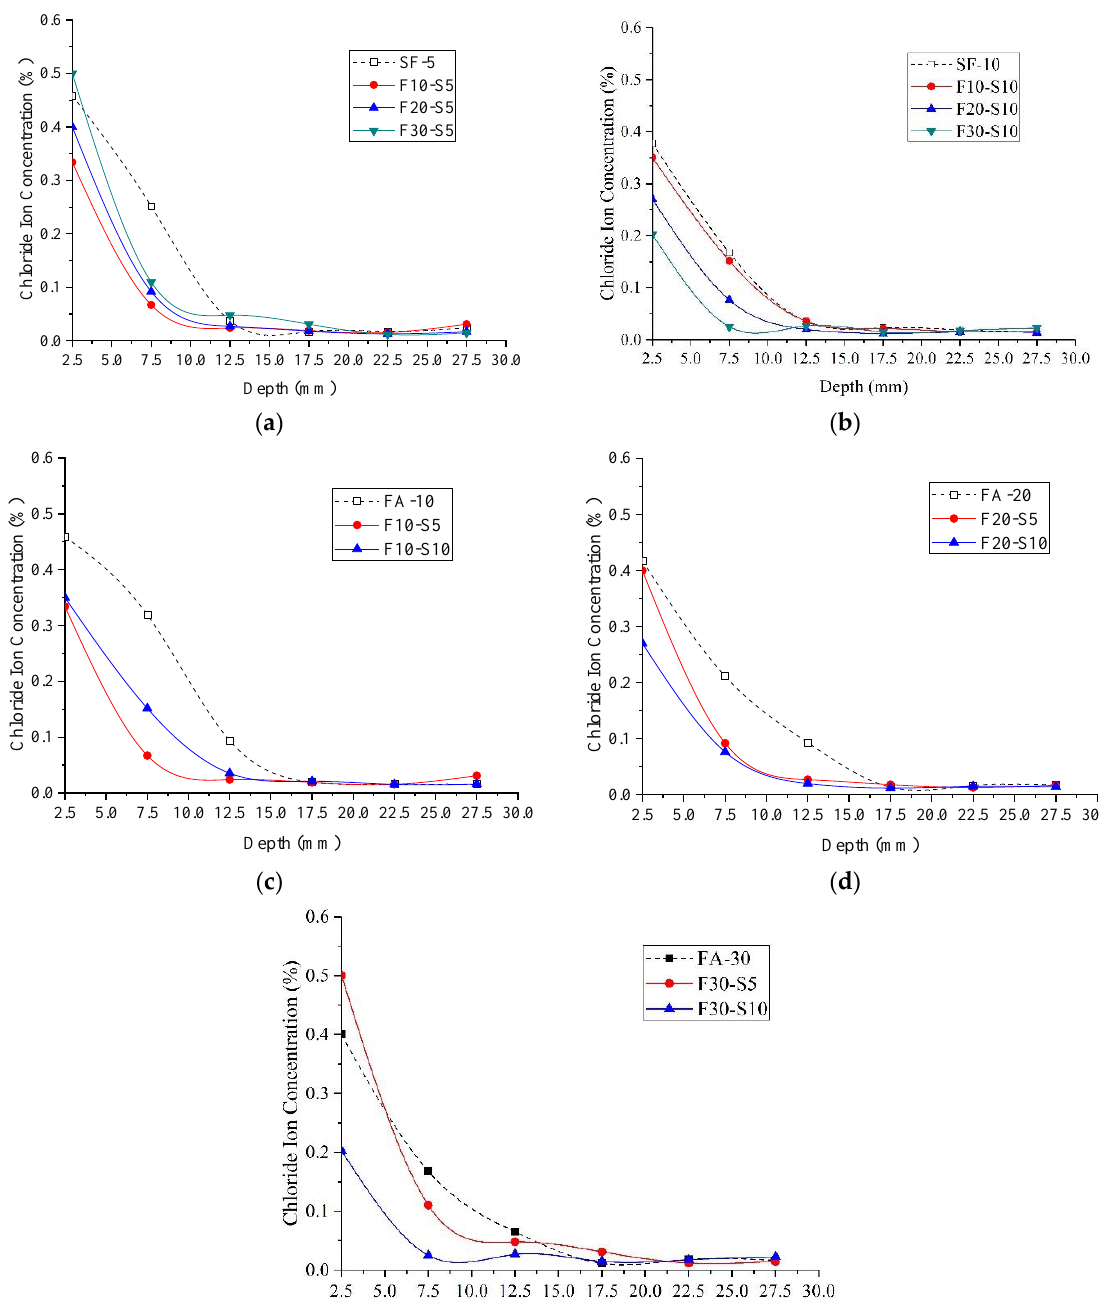
Figure 9. Chloride ion concentration of specimens with binary and ternary blends: ( a , b ) Portland